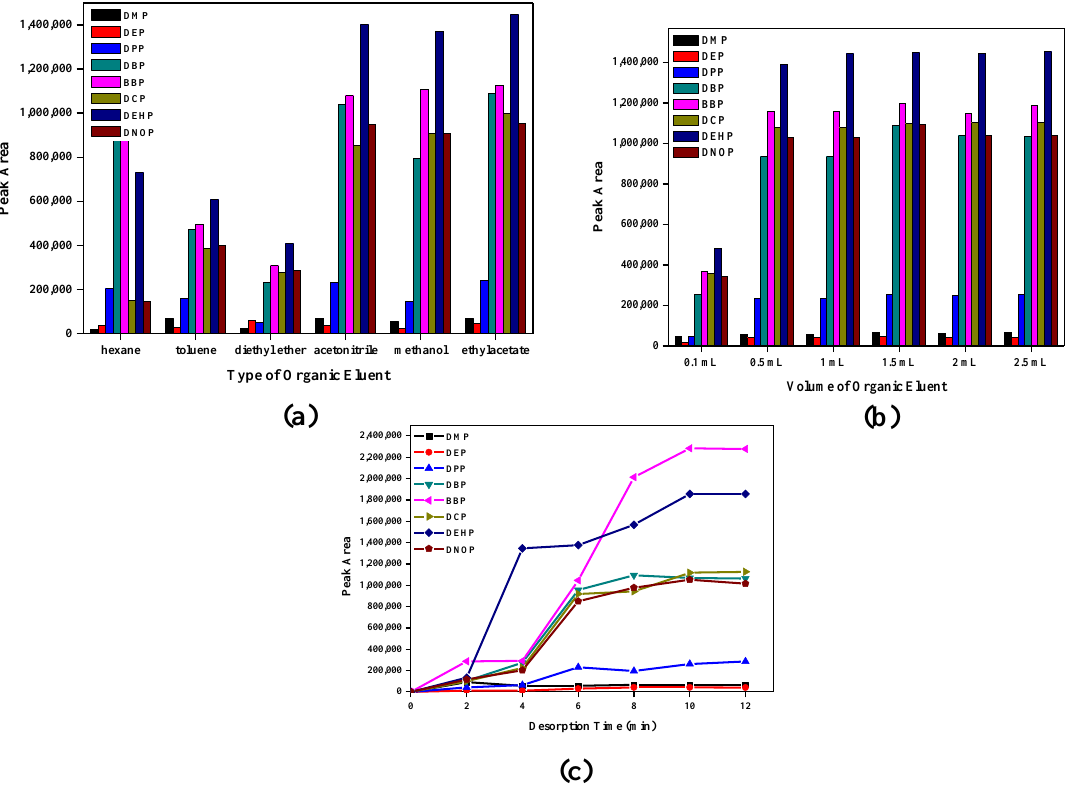
Figure 7. Desorption studies for the extraction of targeted phthalates: ( a ) effect of eluent type; ( b ) volume of organic eluent; ( c ) desorption